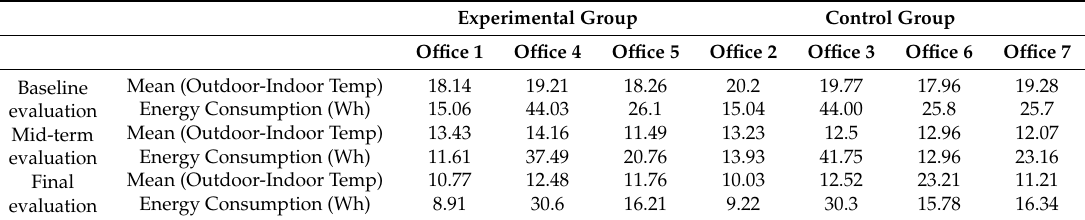
Table 9. Relation between outdoor and indoor temperature difference and energy consumption.